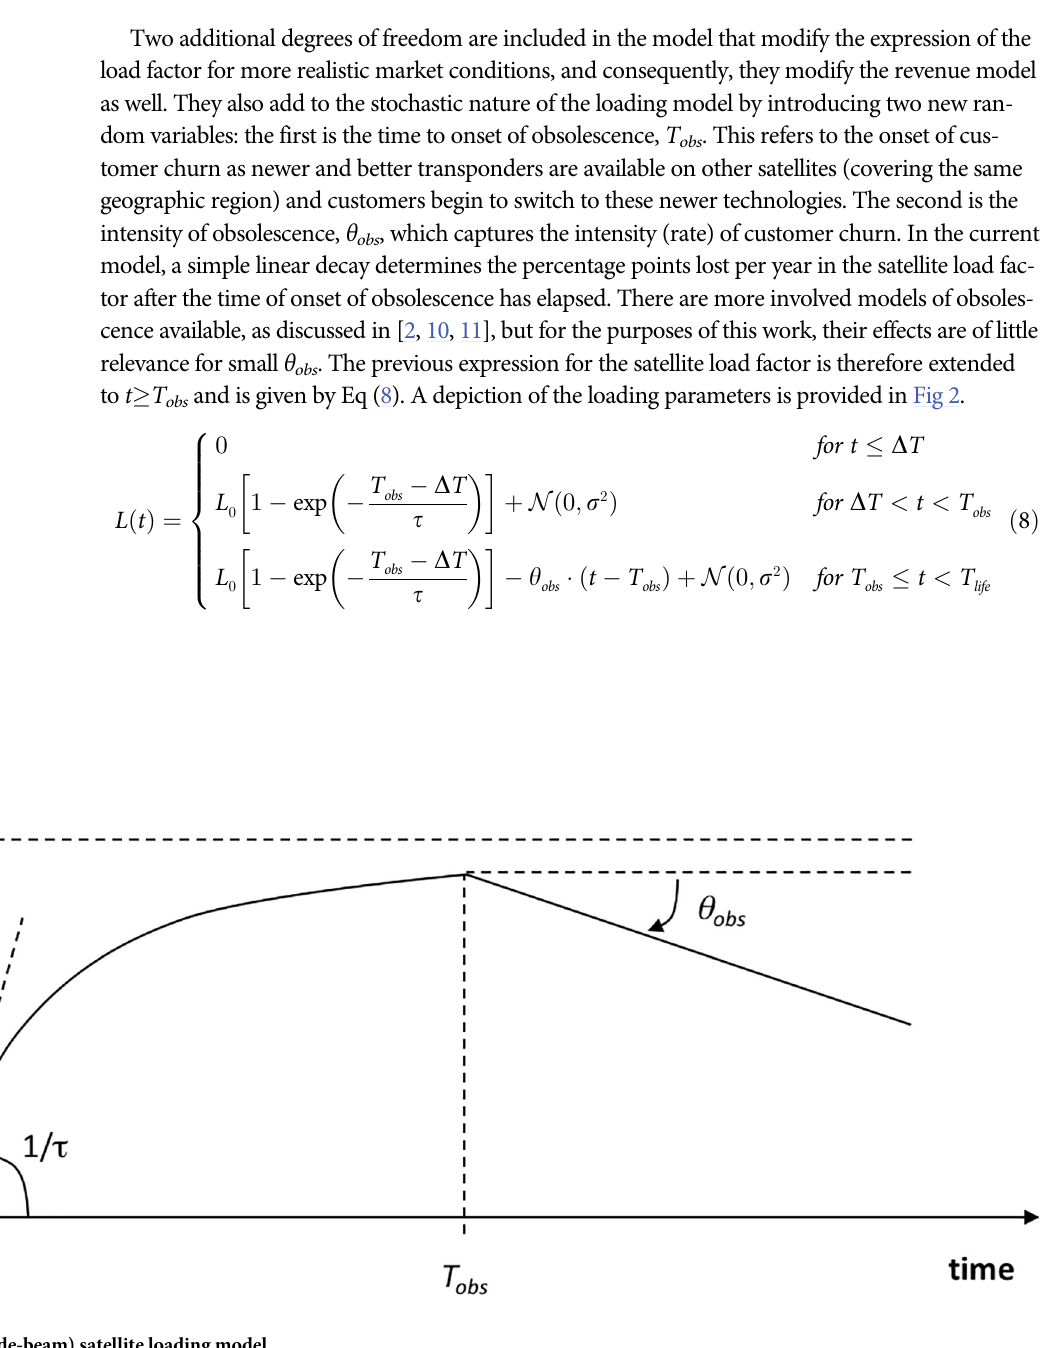
Fig 2. Parameters of our (wide-beam) satellite loading